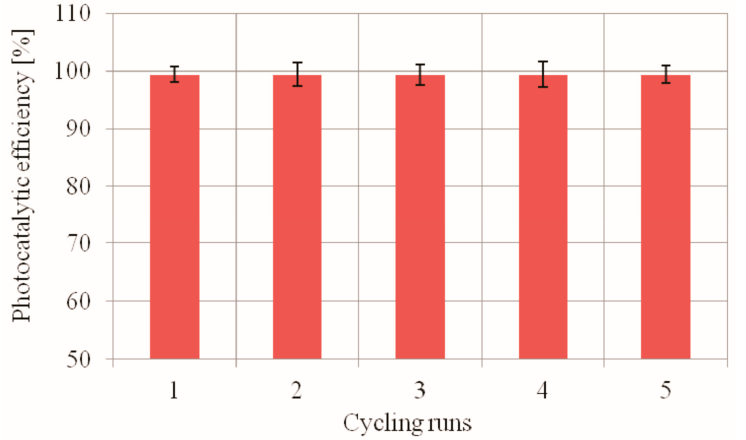
Figure 9. Efficiency of MO degradation as a function of UV irradiation time over PdCl2 biosilica photocatalyst. Experimental conditions: m (biosilica)—10 mg; C 0 (MO)—9.98 mg/L; T = 25 °C; t = 75 min; V (MO solution)—15 mL; pH—7.0.